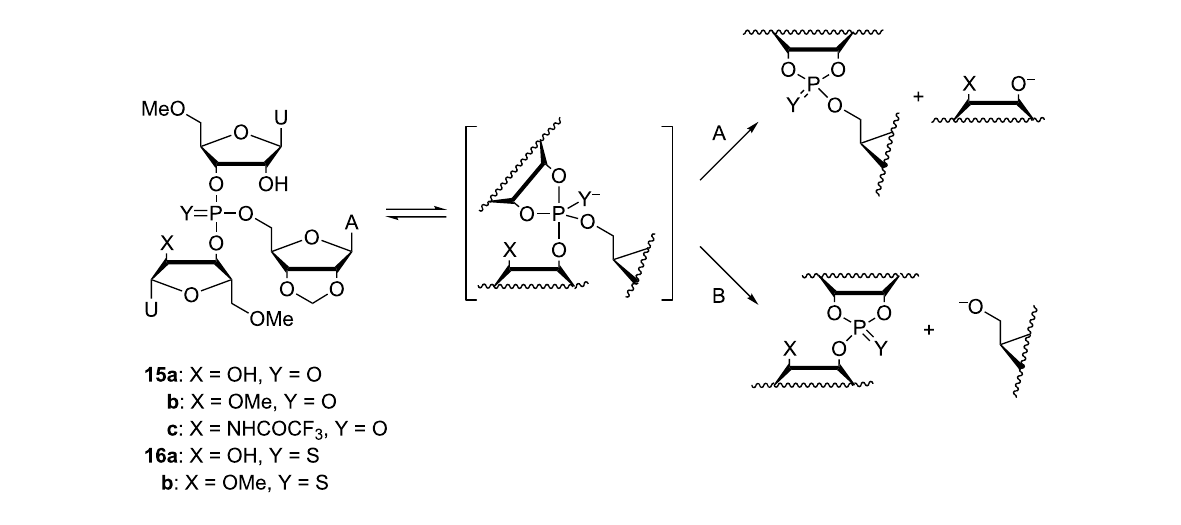
Scheme 13: Cleavage of trinucleoside 3´,3´,5´-monophosphates by A) P–O3´ and B) P–O5´ bond